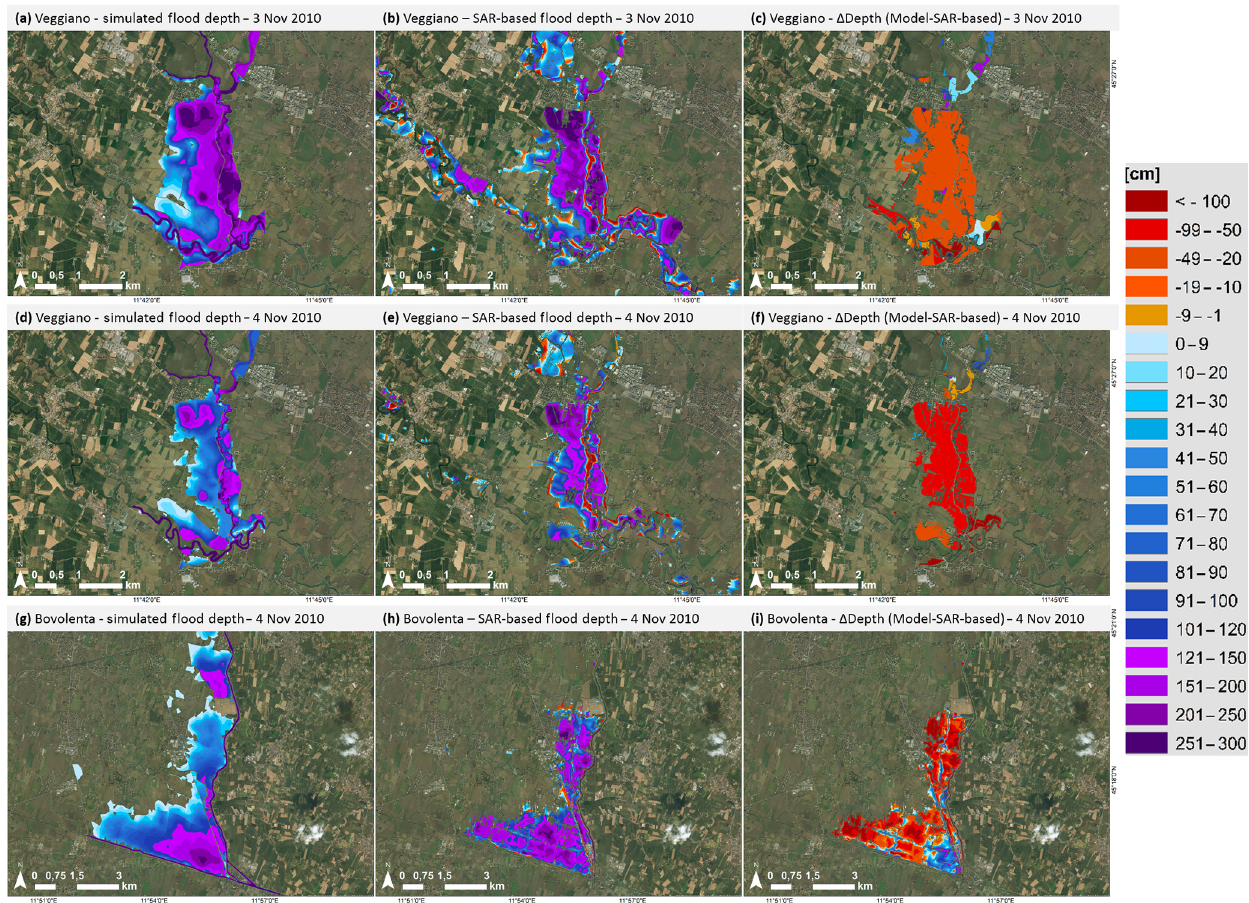
Figure 13. Comparison between the estimated flood extent and depth from the hydrodynamic model and the proposed system based on the same DTM at 5m resolution. (a–c) : simulated flood depth, SAR-based flood depth, and the difference between the two for the Veggiano area on 3 November; (d–f) : simulated flood depth, SAR-based flood depth, and the difference between the two for the Veggiano area on 4 November; (g–i) : simulated flood depth, SAR-based flood depth, and the difference between the two for the Bovolenta area on 4 November.